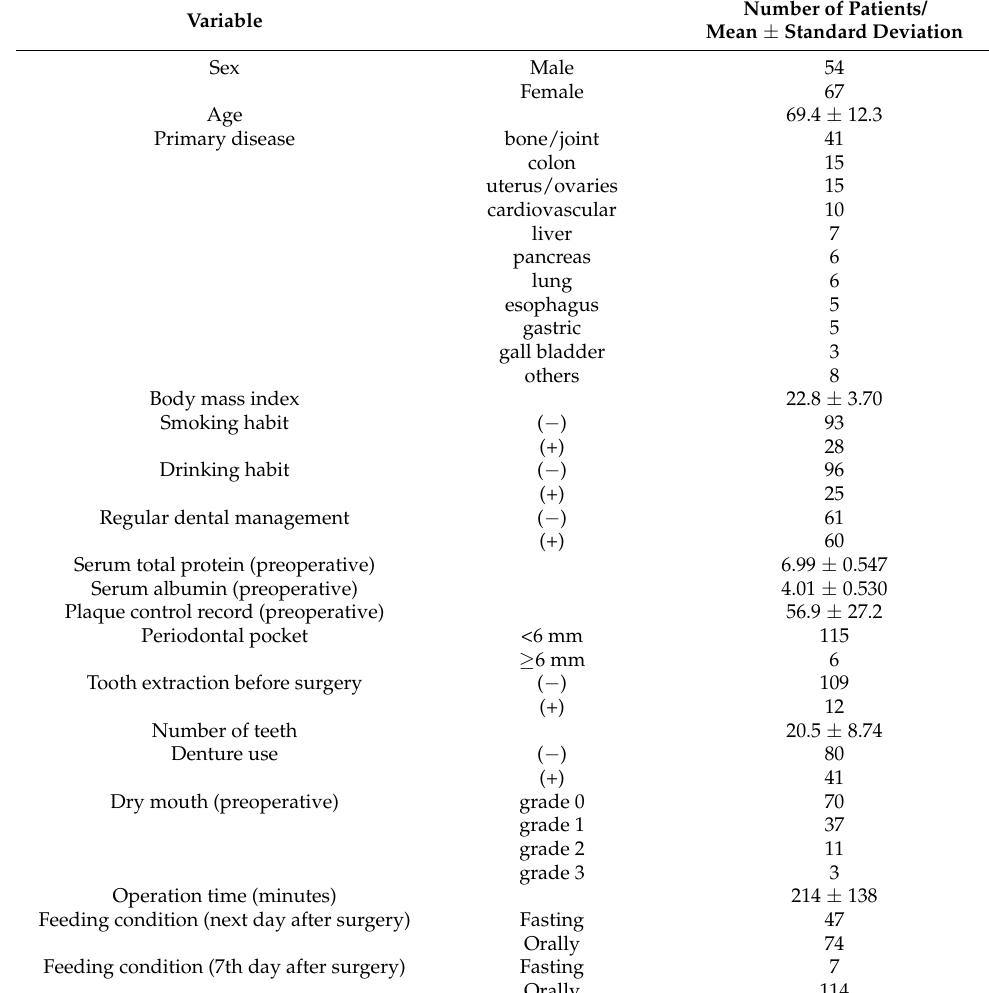
Table 1. Patients’